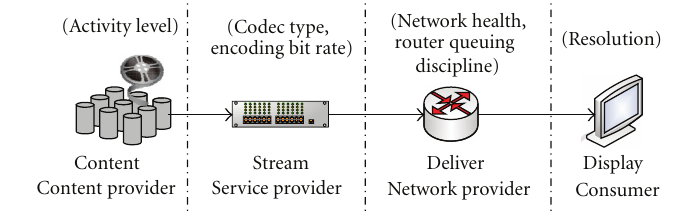
Figure 1: IPTV system components.